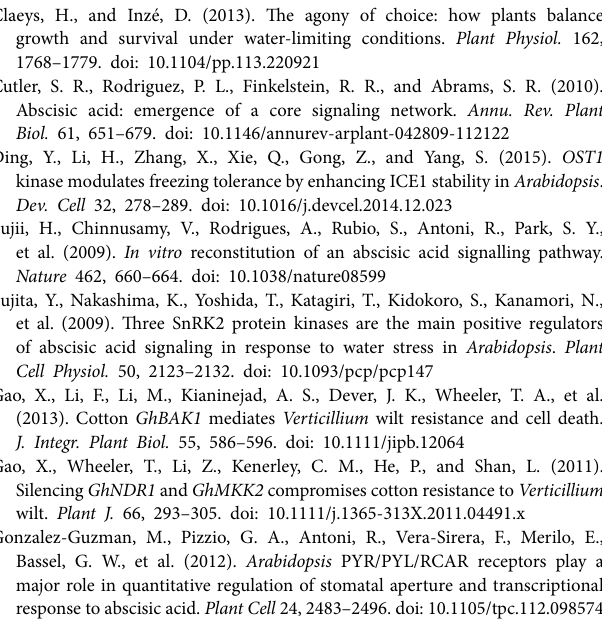
Supplementary Table S1 | List of primer sequences used in this study. Supplementary Figure S1 | (A) Albino appearance on the leaves of TRV2: GhCLA1 plants. (B–D) Verification of GhHAI2 , GhAHG3 , and GhABI2 silencing in VIGS plants by